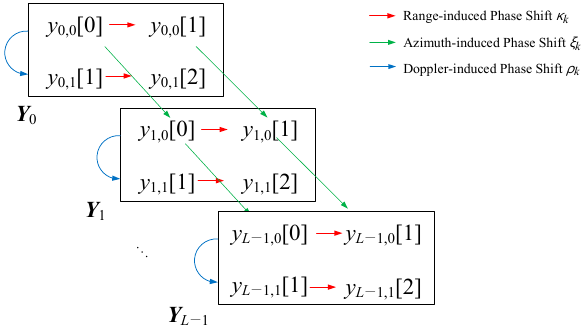
Figure 3. Simplified version of Figure 2.